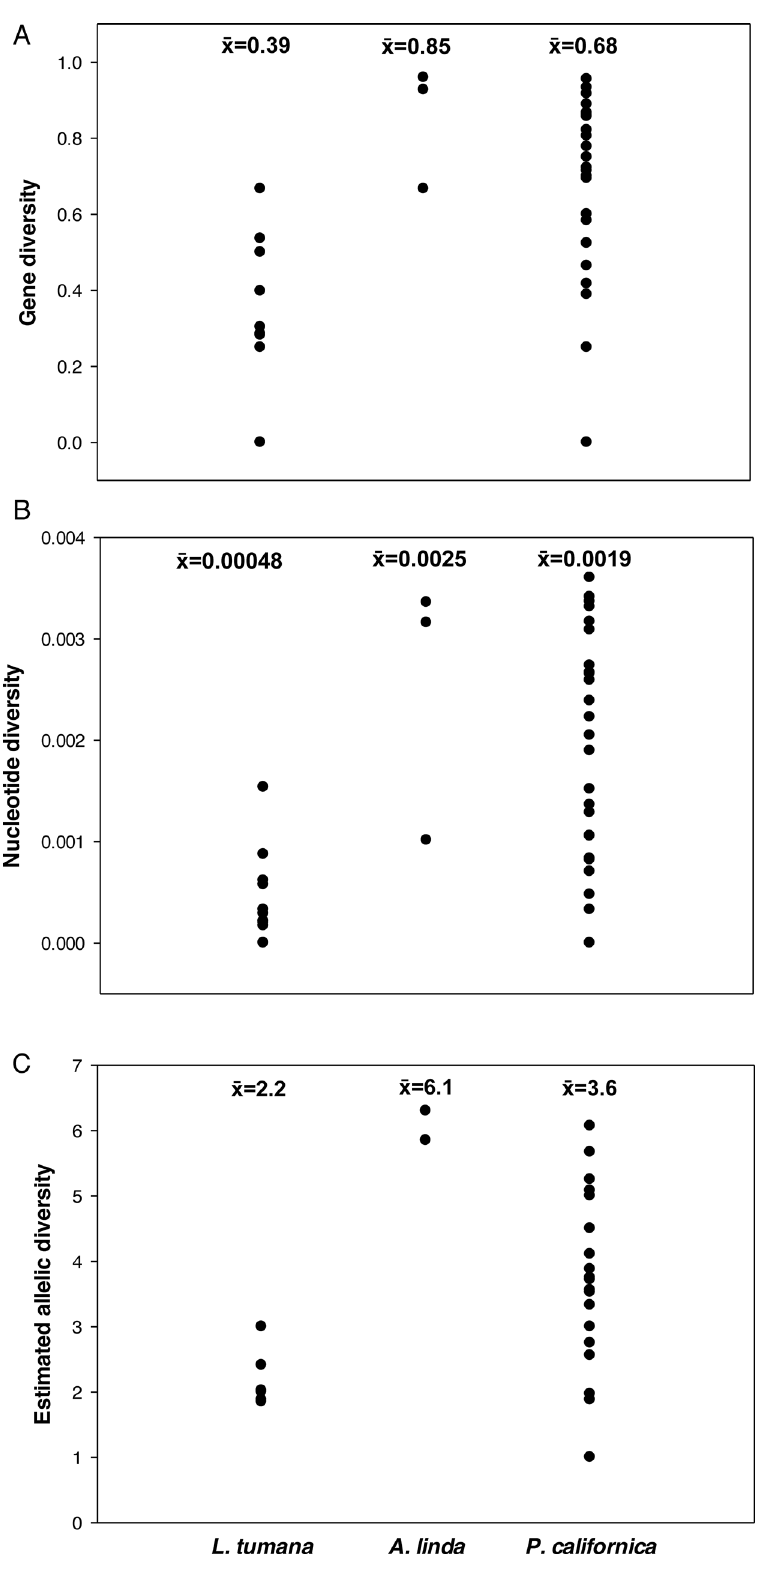
Fig 3. Gene (A), nucleotide (B), and allelic (C) diversity for populations of three species of Plecoptera. Allelic diversity was estimated using the rarefaction method implemented in HP-RARE [28].